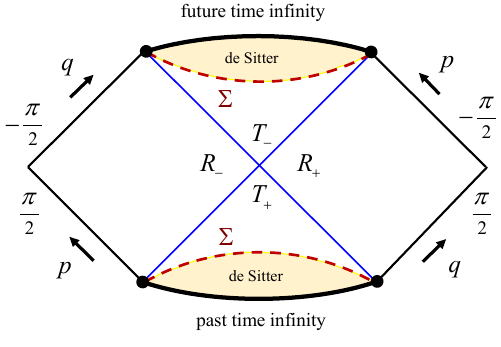
Figure 2. Conformal diagram for the spacetime of the solution of limiting curvature gravity theory which consists of so to say an ‘eternal’ 2D black hole glued to the de Sitter spacetimes. Dashed lines represent junction surfaces where the curvature reaches its maximal value R = Λ